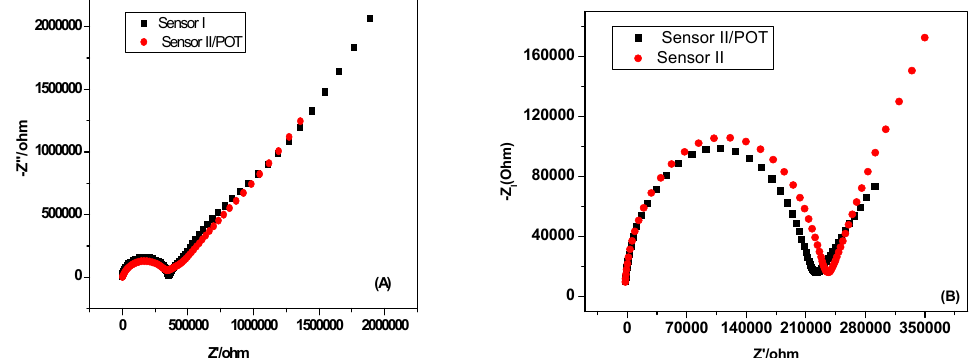
Figure 3. Electrochemical impedance spectroscopy (EIS) measurements of: ( A ) Nit-N 3 and ( B ) FePC membrane based sensors.